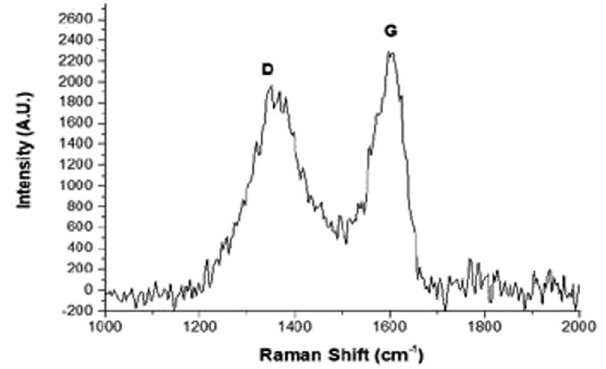
Figure 2: Raman spectroscopy image.